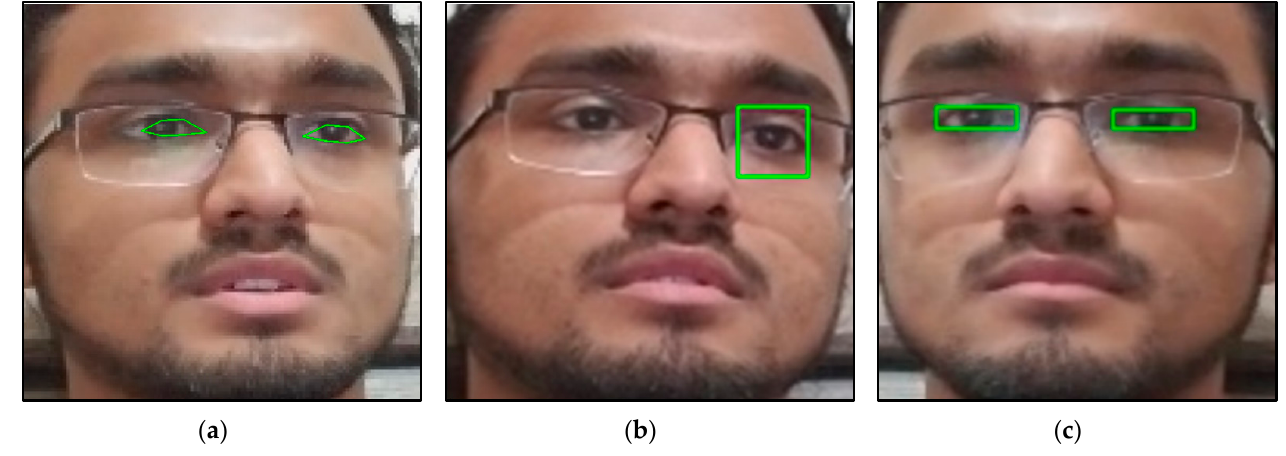
Figure 1. The eye detection results: ( a ) dlib facial landmark, ( b ) Haar-cascade object detection, and ( c ) MediaPipe face mesh. (The ID number of the participants is nine in the UTA-RLDD. The participant claims to allow his image to be published in research papers and publications.).